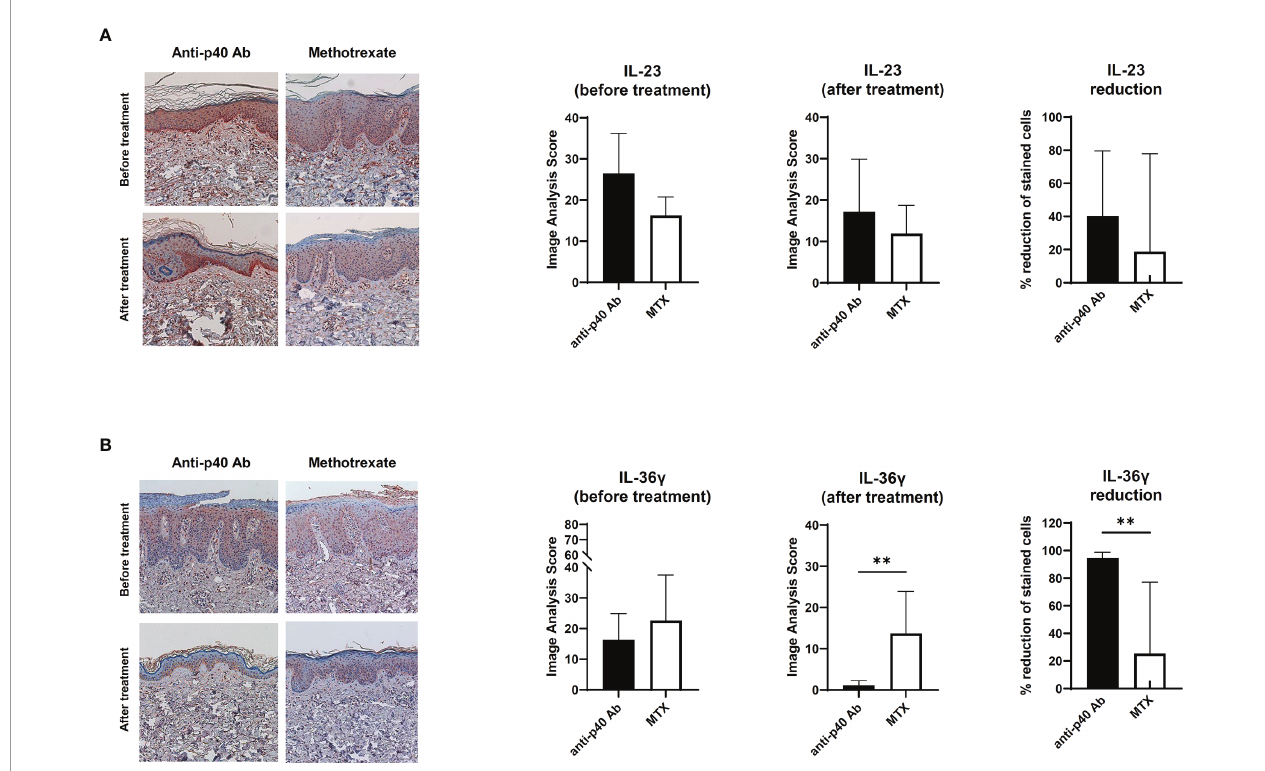
FIGURE 4 | Immunohistochemical analysis of the IL-23 and IL-36 expression in psoriatic epidermis. (A) IL-23 expression on paraf fi n-embedded sections of biopsies obtained from psoriatic skin treated with anti-p40 monoclonal antibody (ustekinumab) (n=8) and methotrexate-treated skin (n=9). (B) IL-36 g expression on paraf fi n- embedded sections of biopsies obtained from psoriatic skin treated with anti-p40 monoclonal antibody (ustekinumab) (n=8) and methotrexate-treated skin (n=9). Lines above bars indicate statistical comparisons with signi fi cant differences between categories (** P < 0.01). Data represent two independent